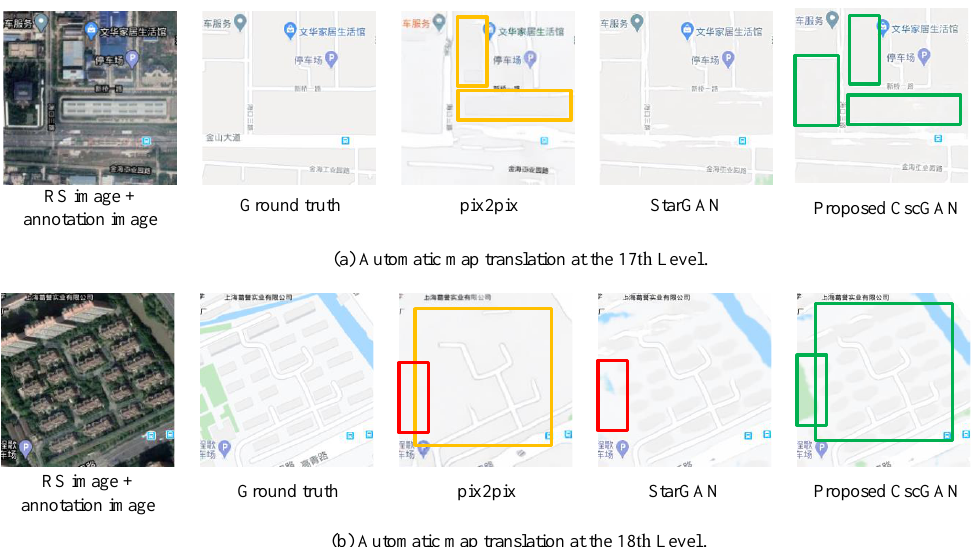
Figure 1. Generated results at multiple levels using different models. ( a ) Automatic map translation at the 17th Level. From left to right: RS image + annotation image, Ground truth, by pix2pix, by Star- GAN and by the proposed CscGAN. ( b ) Automatic map translation at the 18th Level. From left to right: RS image + annotation image, Ground truth by pix2pix, by StarGAN and by the proposed CscGAN. Note: in generated mappings, red rectangles represent loss contents; yellow rectangles represent confused contents; green rectangles represent the correct contents generated by the pro- posed